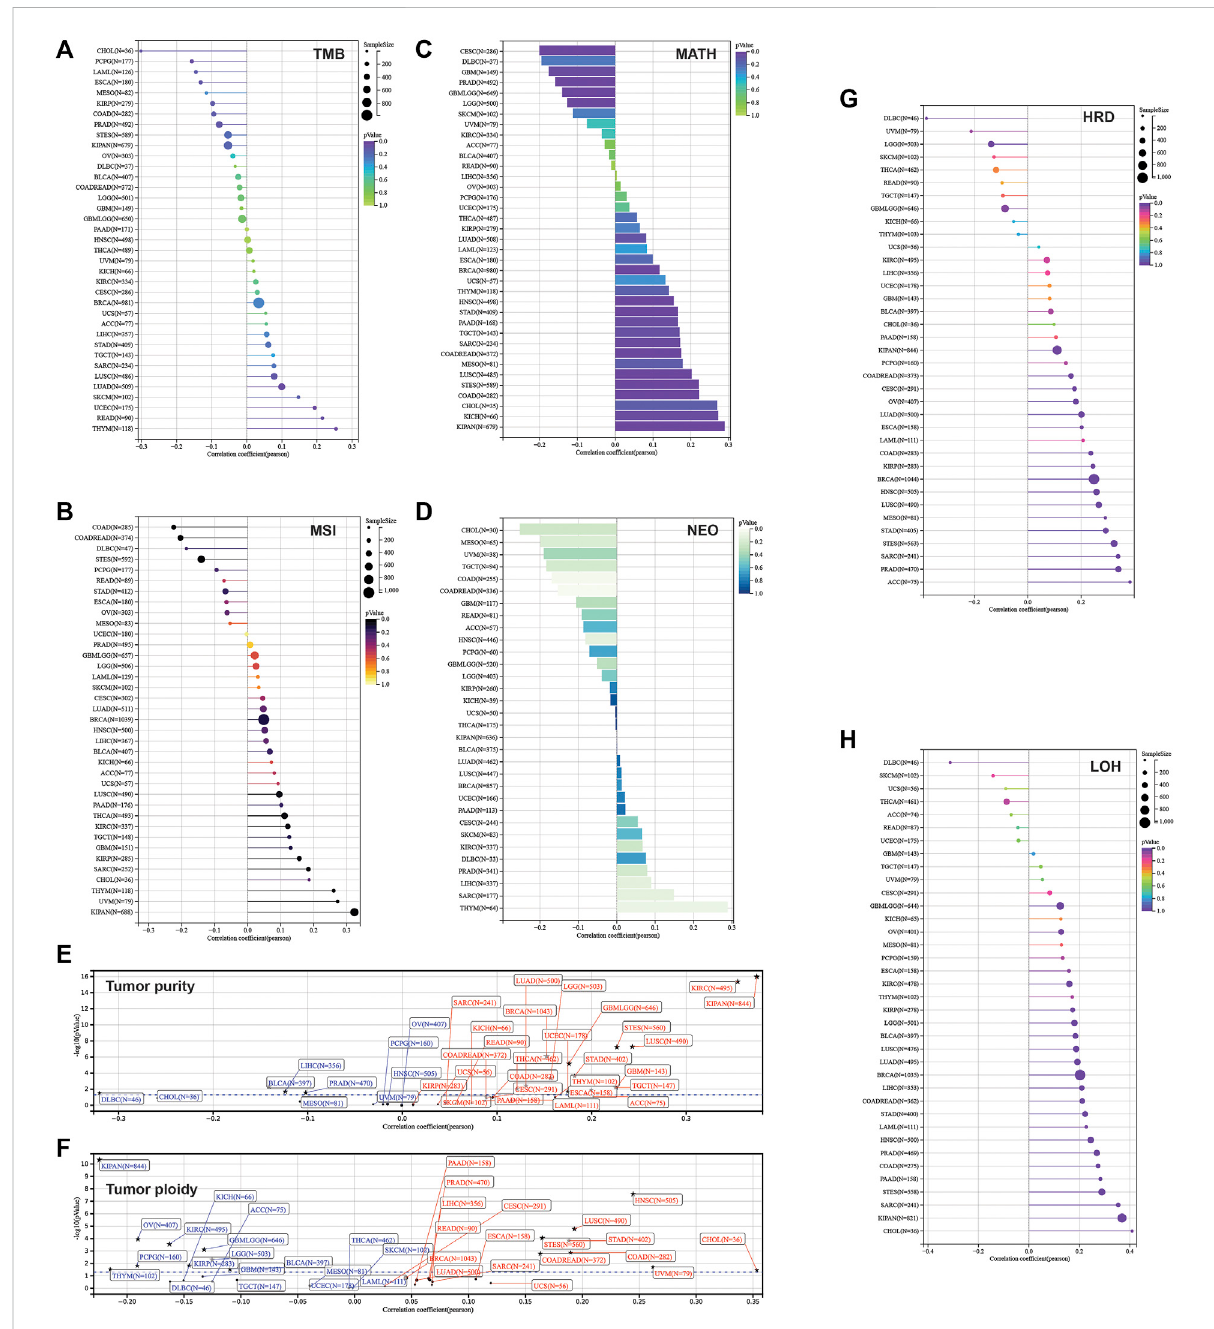
FIGURE 8 Correlation between parameters of genetic instability and SLC3A2 expression. (A) TMB. (B) MSI. (C) MATH. (D) NEOANTIGEN. (E) Tumor purity. (F) Tumor ploidy. (G) HRD. (H)